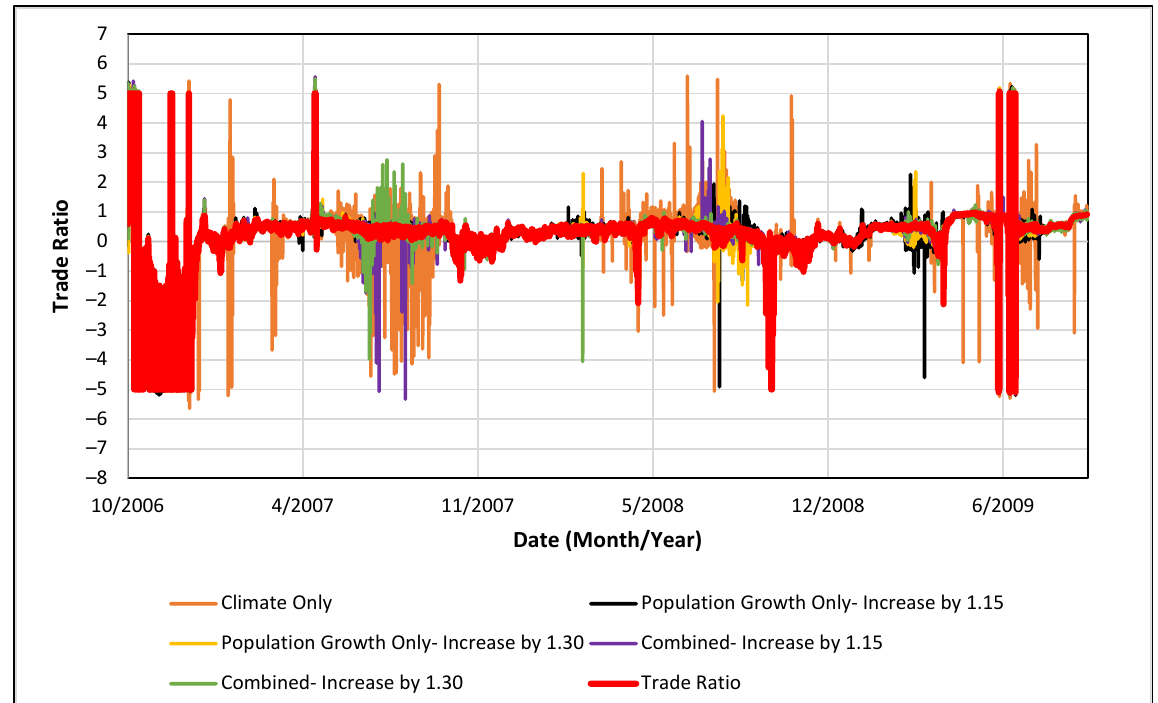
Figure 11. Composite Trade Ratio based on Sums for Delivery + Downstream Components with Equivalency Adjustments for Theoretical WQT Buyer TP Combined with Suggested Margins of Safety for Climate and Population Characteristics over the Jordan River Simulation Period (1 October 2006 to 30 September 2009) for RCP 8.5.